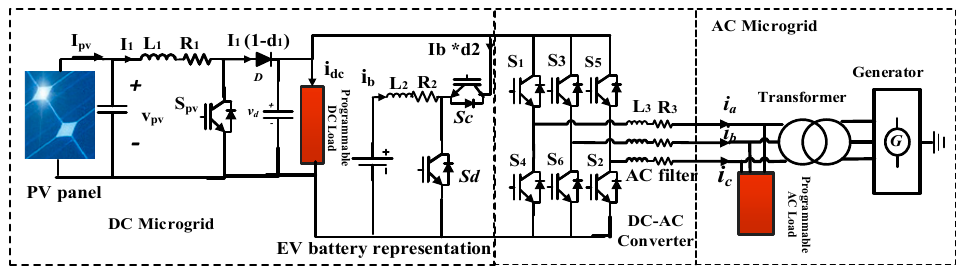
Figure 11. Schematic illustration of the hybrid microgrid connection at our testbed.